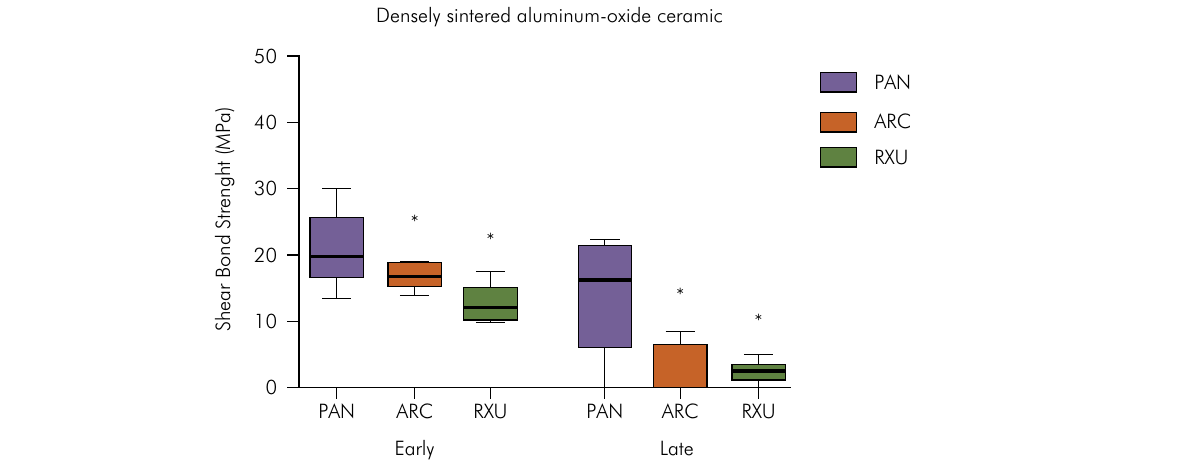
Table 3. Percentage distribution of failure modes per ceramic group. Feldspathic Leucite-reinforced feldspathic Densely sintered aluminum-oxide Variable Non-thermocycled